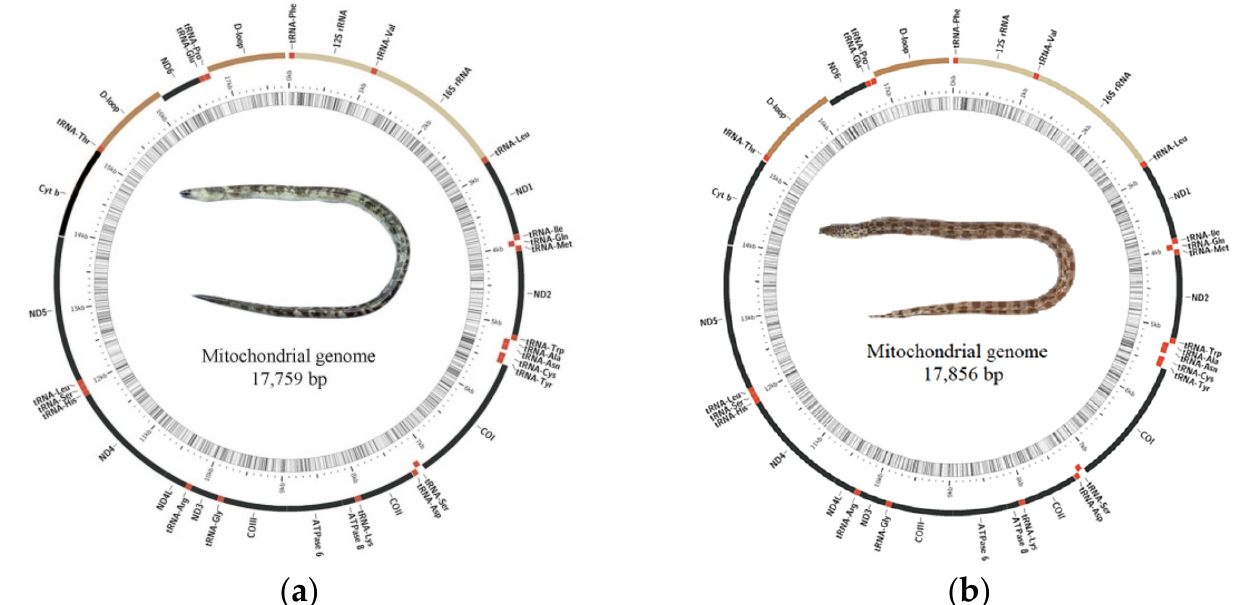
Figure 1. Circular mitochondrial genome maps of two Ophichthus fishes. ( a ) O. evermanni and ( b ) O. erabo . Table 1. Features of the mitochondrial genomes of two Ophichthus species.